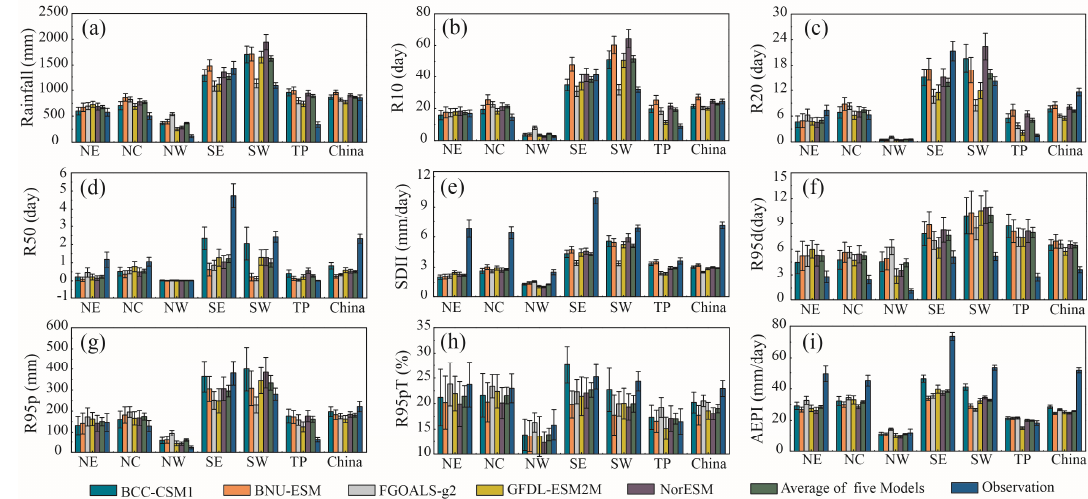
Figure A1. Averages of EPIs in China calculated from five CMIP5 models, average of the five models and the observations from 1960 to 2005: ( a ) annual average rainfall, ( b ) annual average R10, ( c ) annual average R20, ( d ) annual average R50, ( e ) annual average SDII, ( f ) annual average R95d, ( g ) annual average R95p, ( h ) annual average R95pT, and ( i ) annual average in AEPI .